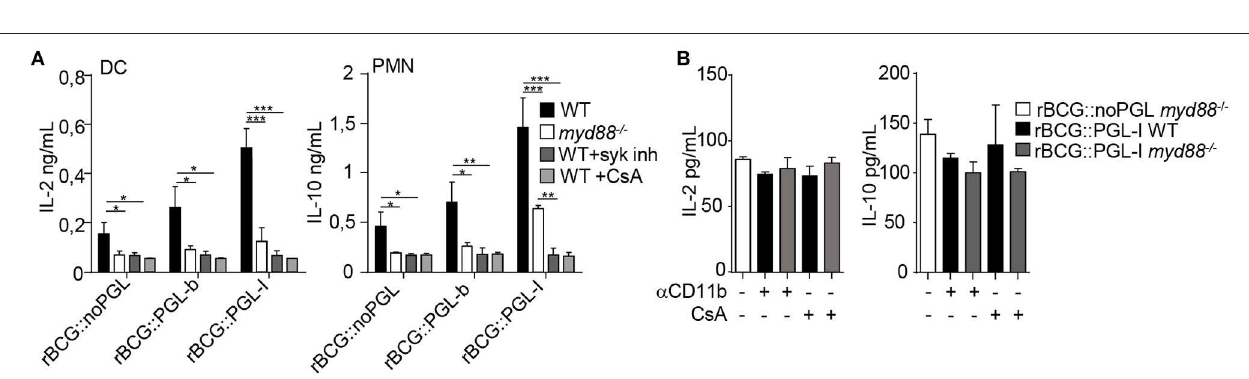
FIGURE 4 | BCG strains at MOI of 5. Data are presented as mean ± SEM. ** P < 0.01; *** P < 0.001. (A) Phagocytosis was blocked by treatment for 1h before infection with 1 or 50nM of CytoD, while controls received only the vehicle DMSO ( n = 8). (B) Cells were treated with two NFATc inhibitors tacrolimus (FK506, 500 pg/ml) or Cyclosporin (CsA, 50ng/ml) 1h before infection by the three rBCG strains. Controls received DMSO ( n = 4). (C) For PGE2 production, cells were derived from bone marrow of WT or itgam − / − mice. (D) Translocation of NFATc2 (green) into the nucleus of MPs (blue, DAPI staining) derived from bone marrow of WT or itgam − / − mice was analyzed by confocal microscopy 30min after infection with rBCG::PGL-I or rBCG::noPGL at MOI of 5. Cells on slides were then fixed, permeabilized and stained with anti-NFATc2 and mounted in medium containing DAPI. Images were acquired with a confocal Leica TCS SP8 microscope, where NFATc2 colocalization with the nucleus appeared in light blue, while NFATc2 remaining in the cytosol appeared in green. Images are from original magnification × 63. (E) After analysis of images (Image J software) the Manders coefficient was determined with the JACoP (26) plugin that allowed to quantify colocalization of NFATc2 with the nucleus (light blue). These coefficients were calculated in 10 fields from 4 slides (obtained from 2 independent experiments). Box and whisker plot shows median ± SEM. *** P < 0.001 (Student’s t -test). (F) Cytokine production measured as in (A,B) from WT or itgam − / − cells stimulated with rBCG::PGL-I at MOI of 5 or